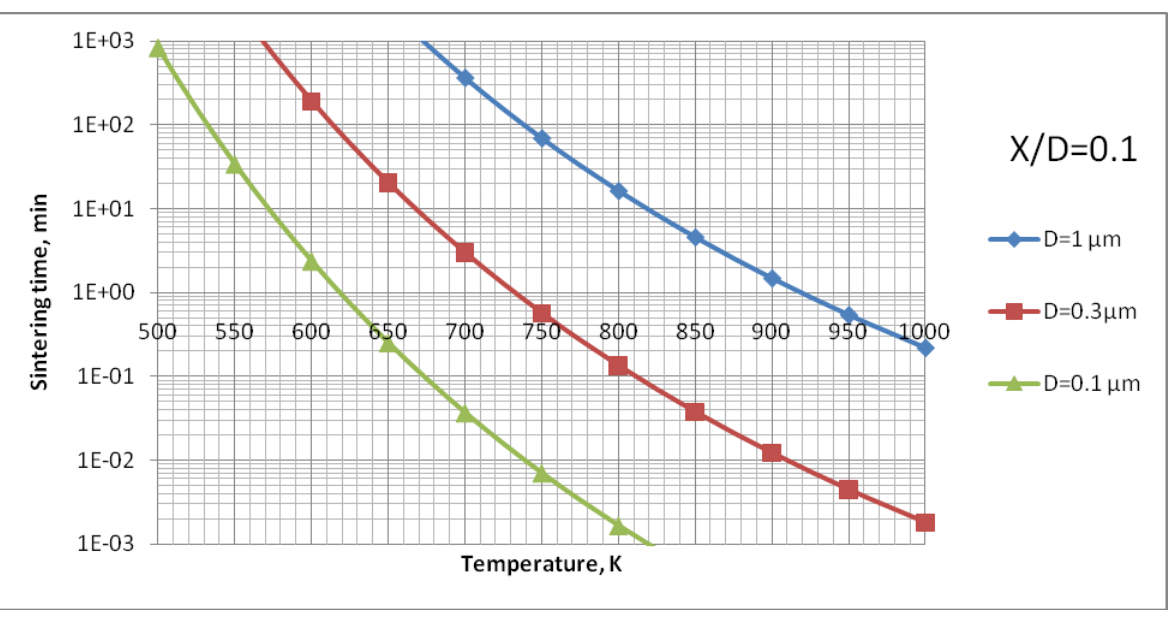
Figure 11. Sintering time of TiO with an initial diameter of D = 0.1; 0.3 or 1 μm to reach 2 the neck size of X / D = 0.1 vs. temperature for surface diffusion mechanism (case of suspension plasma spraying with an internal